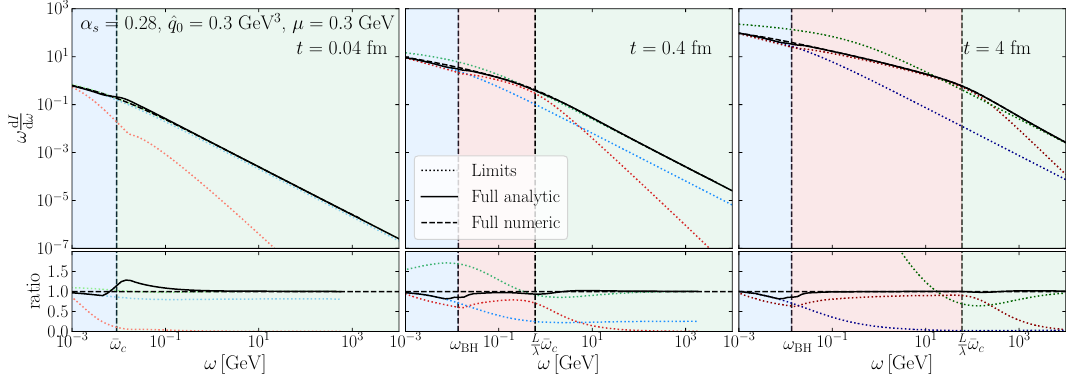
Figure 7 . Summary of the induced emission spectrum for gluons, combined from the three expansion schemes at different propagation length (different panels). The black lines are our final forms from eq. (3.64) that uses N r = 1 and HO+NHO. The shaded areas denote the leading scattering process and the corresponding dotted lines are the limiting N = 1 , HO and N r = 1 contributions. The dashed lines are the numerical solution of eq. (3.1) from ref.